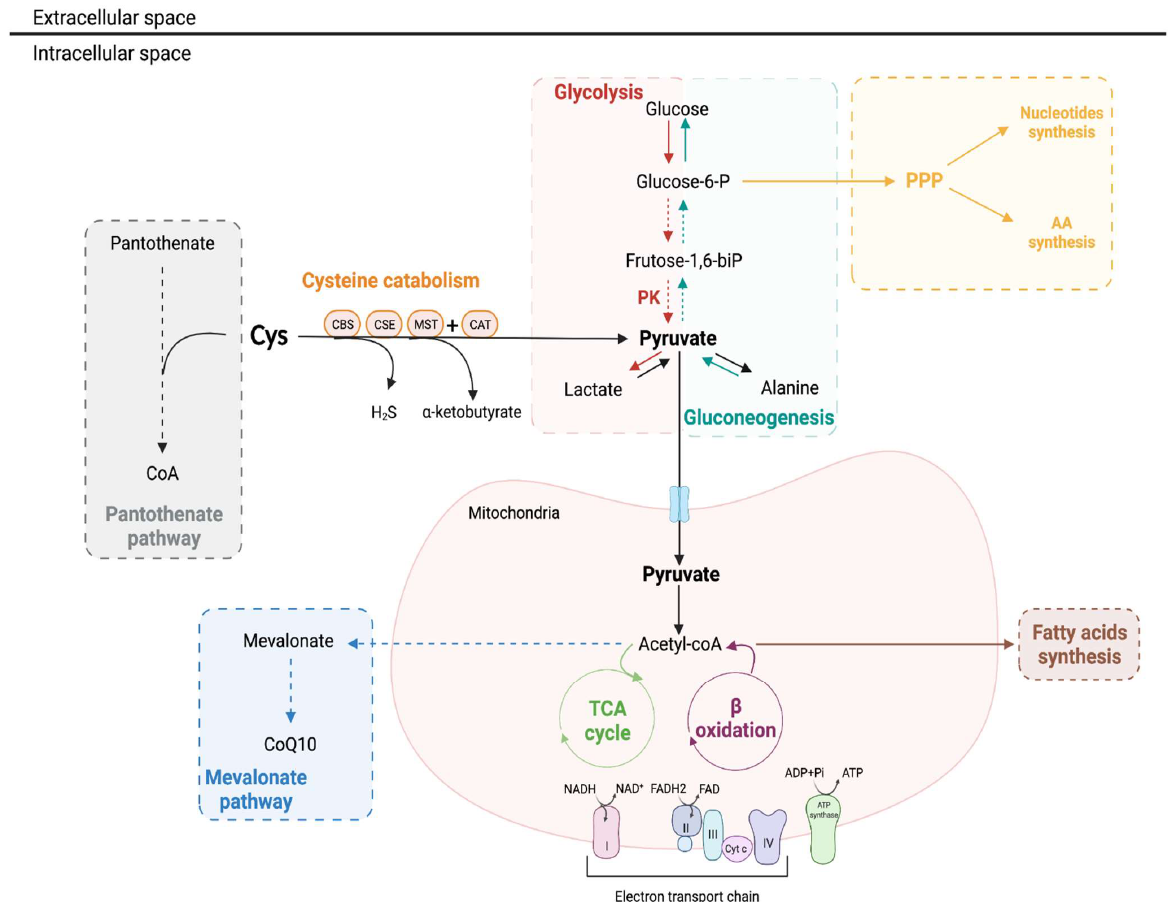
Figure 5. Cysteine metabolism as a source for biomass and bioenergetics. Cys catabolism